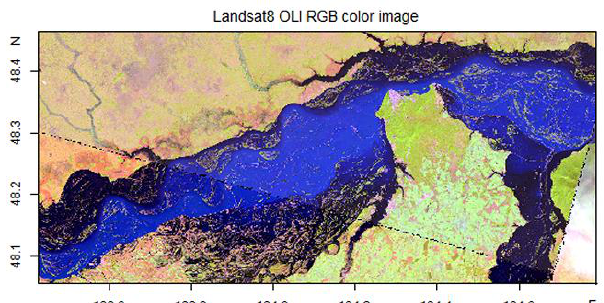
Figure 3. The reference 30-meter Landsat-8 OLI image showing the severe flood after riverbank